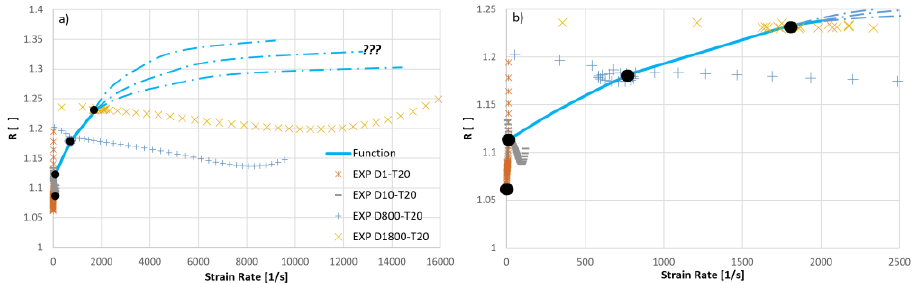
Fig. 8. Dynamic amplification versus strain rate at different magnification